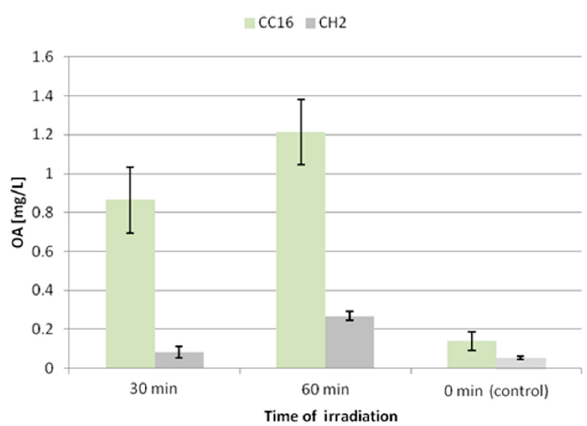
Figure 9. The content of oleanolic acid in the medium after elicitation with UV radiation. OA—oleanolic acid.